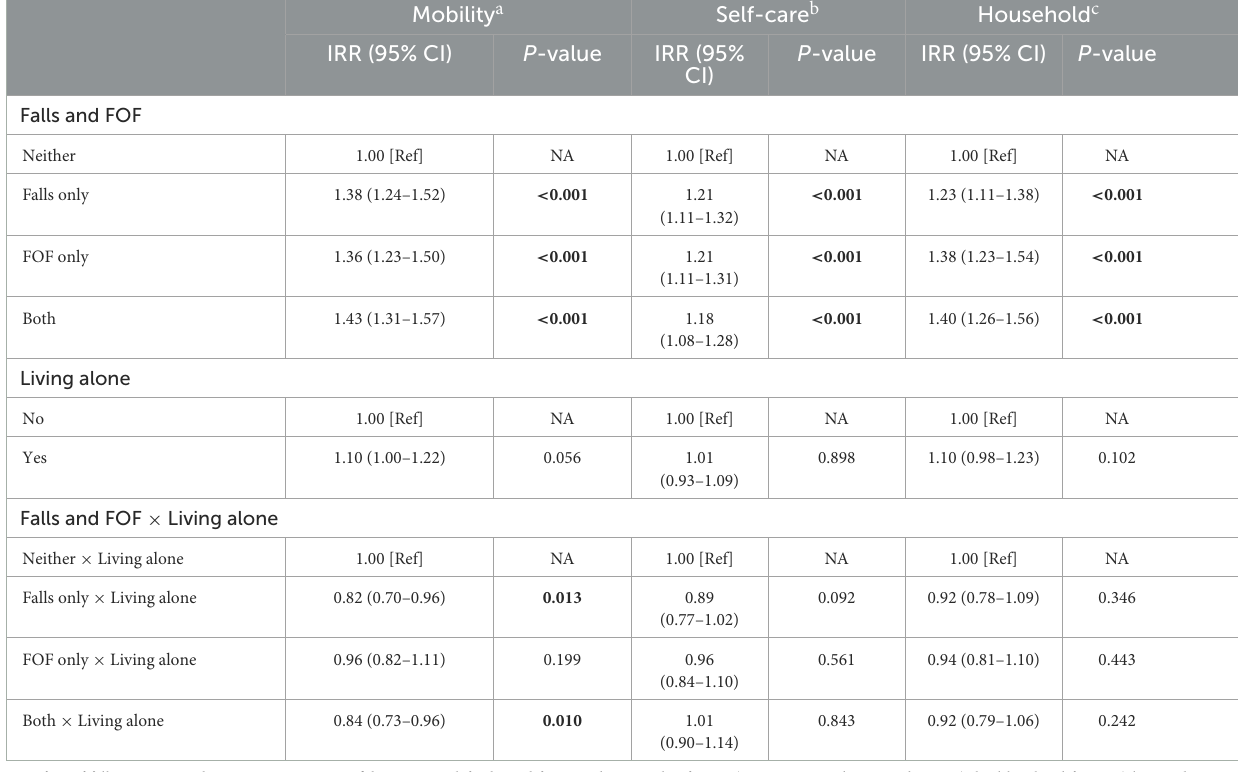
TABLE 2 Fully adjusted Poisson regression examining the association of living alone and concurrent falls and FOF at baseline with functional limitations outcomes at follow-up.